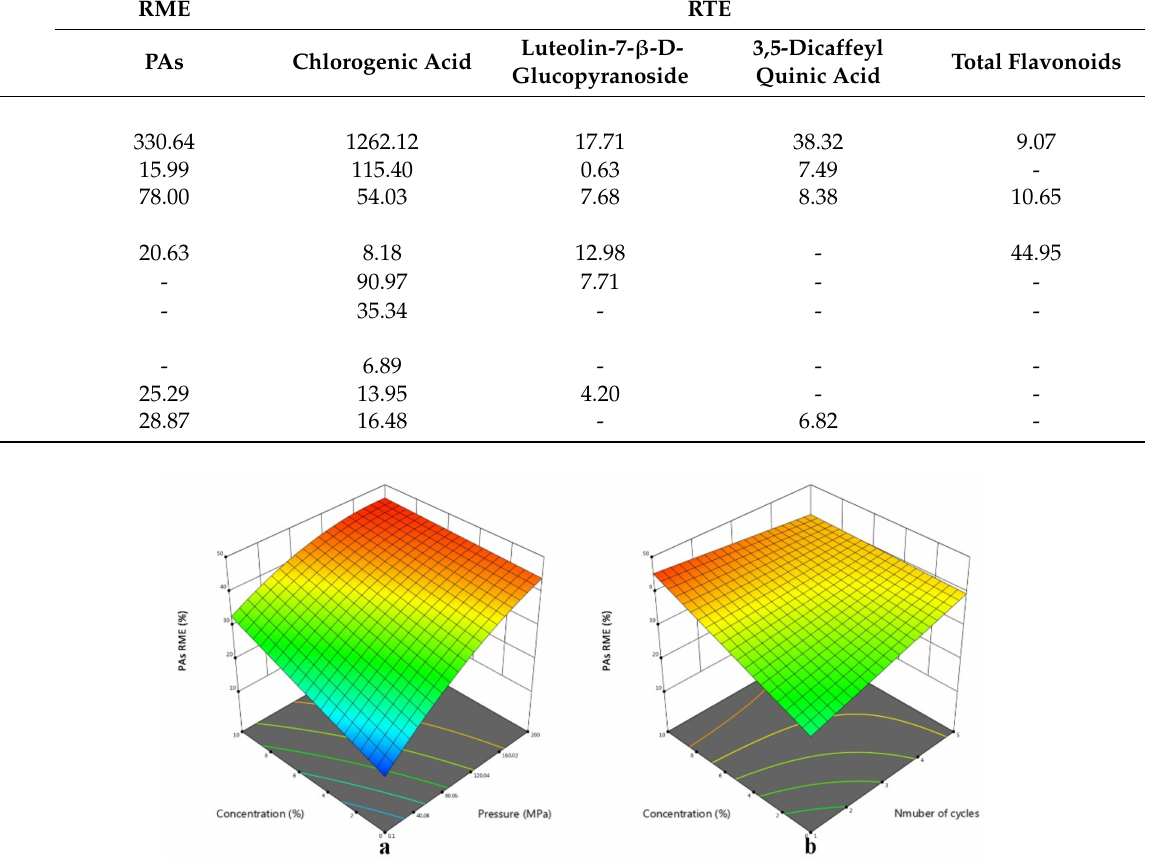
Figure 2. 3D surface plots of PAs’ RME: ( a ) pressure–concentration; ( b ) number of